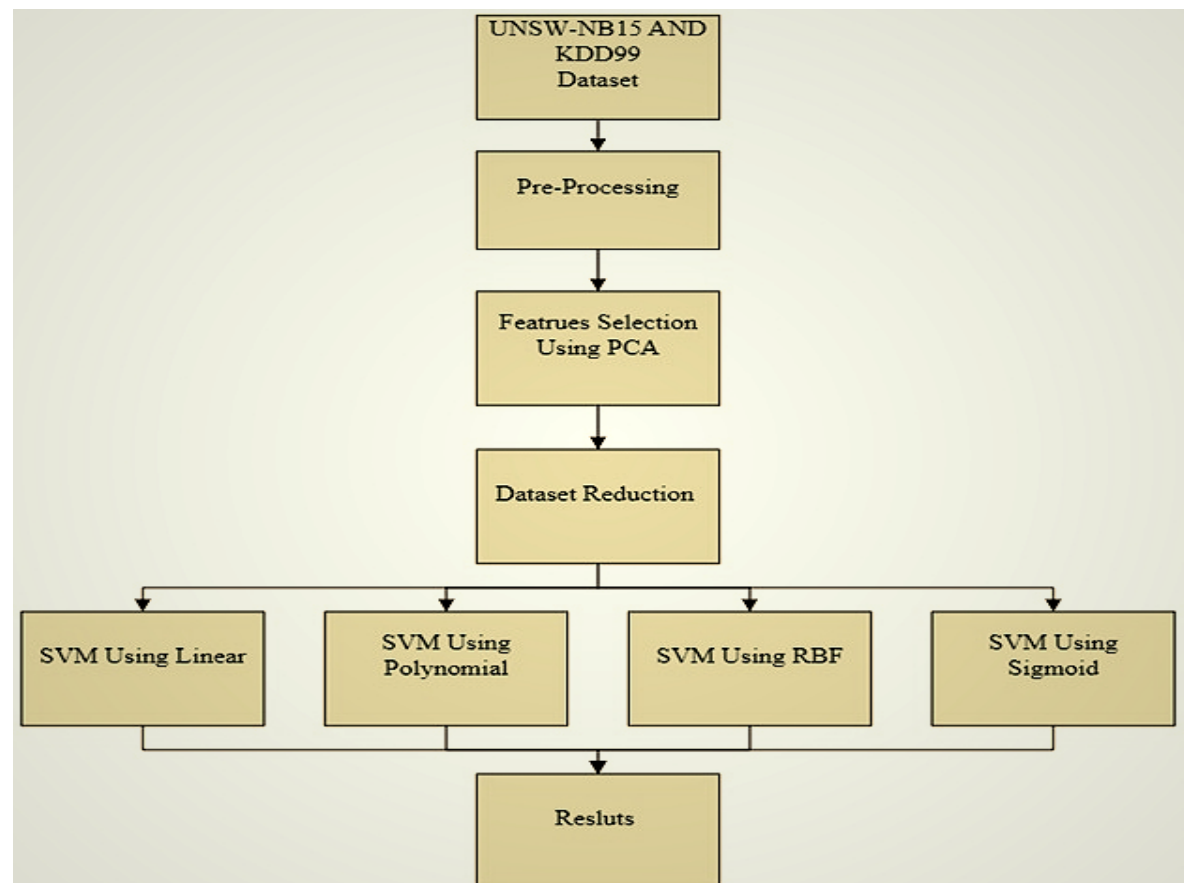
Figure 4. architecture of investigation model for IDS using PCA and SVM kernels. Figure 4. Architecture of investigation model for IDS using PCA and SVM